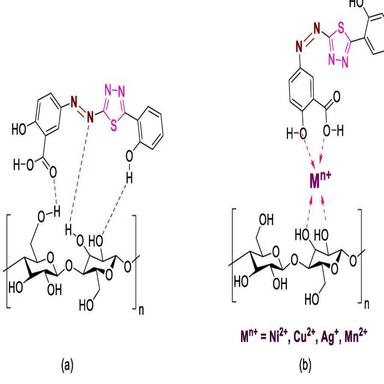
The plausible binding of dye 1b to cellulose: (a) in the absence of metal ions and (b) in the presence of metal ions.